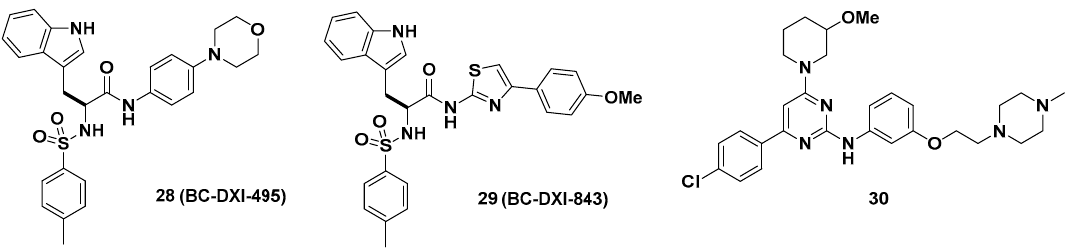
Figure 11. Aminoacyl-tRNA synthetase-interacting multifunctional protein 2 lacking exon 2 (AIMP2-DX2) interaction inhibitors.